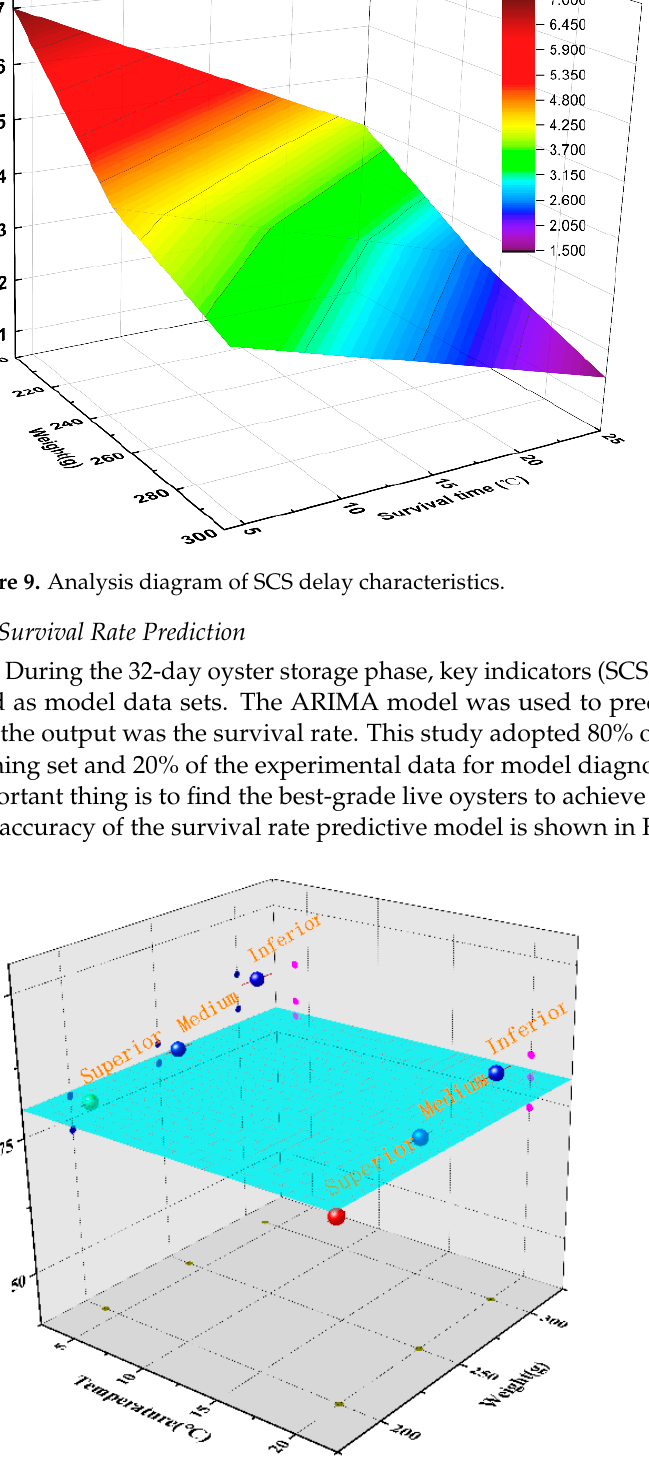
Figure 10. Prediction results for oyster survival.